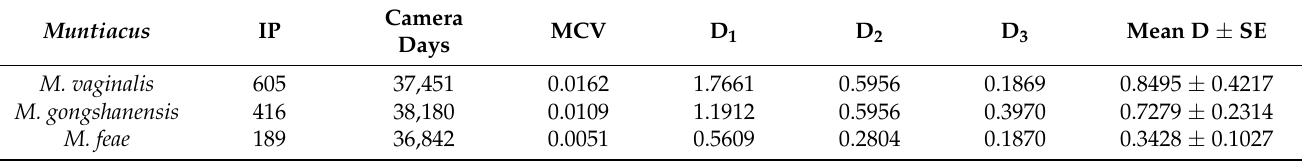
Table 2. Muntiacus population densities estimated by the infrared triggered camera technique in the Yarlung Zangbo Grand Canyon National Nature Reserve, Tibet, from 2013 to